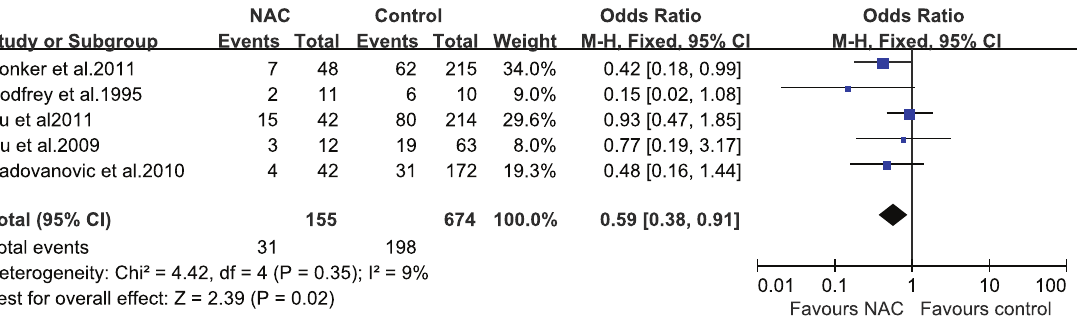
Figure 2. Pooled results of overall complications in patients treated with NAC. The size of the solid squares is inversely proportional to the variance of the study estimate. The diamond represents the fixed effects odds ratio and 95% confidence interval.